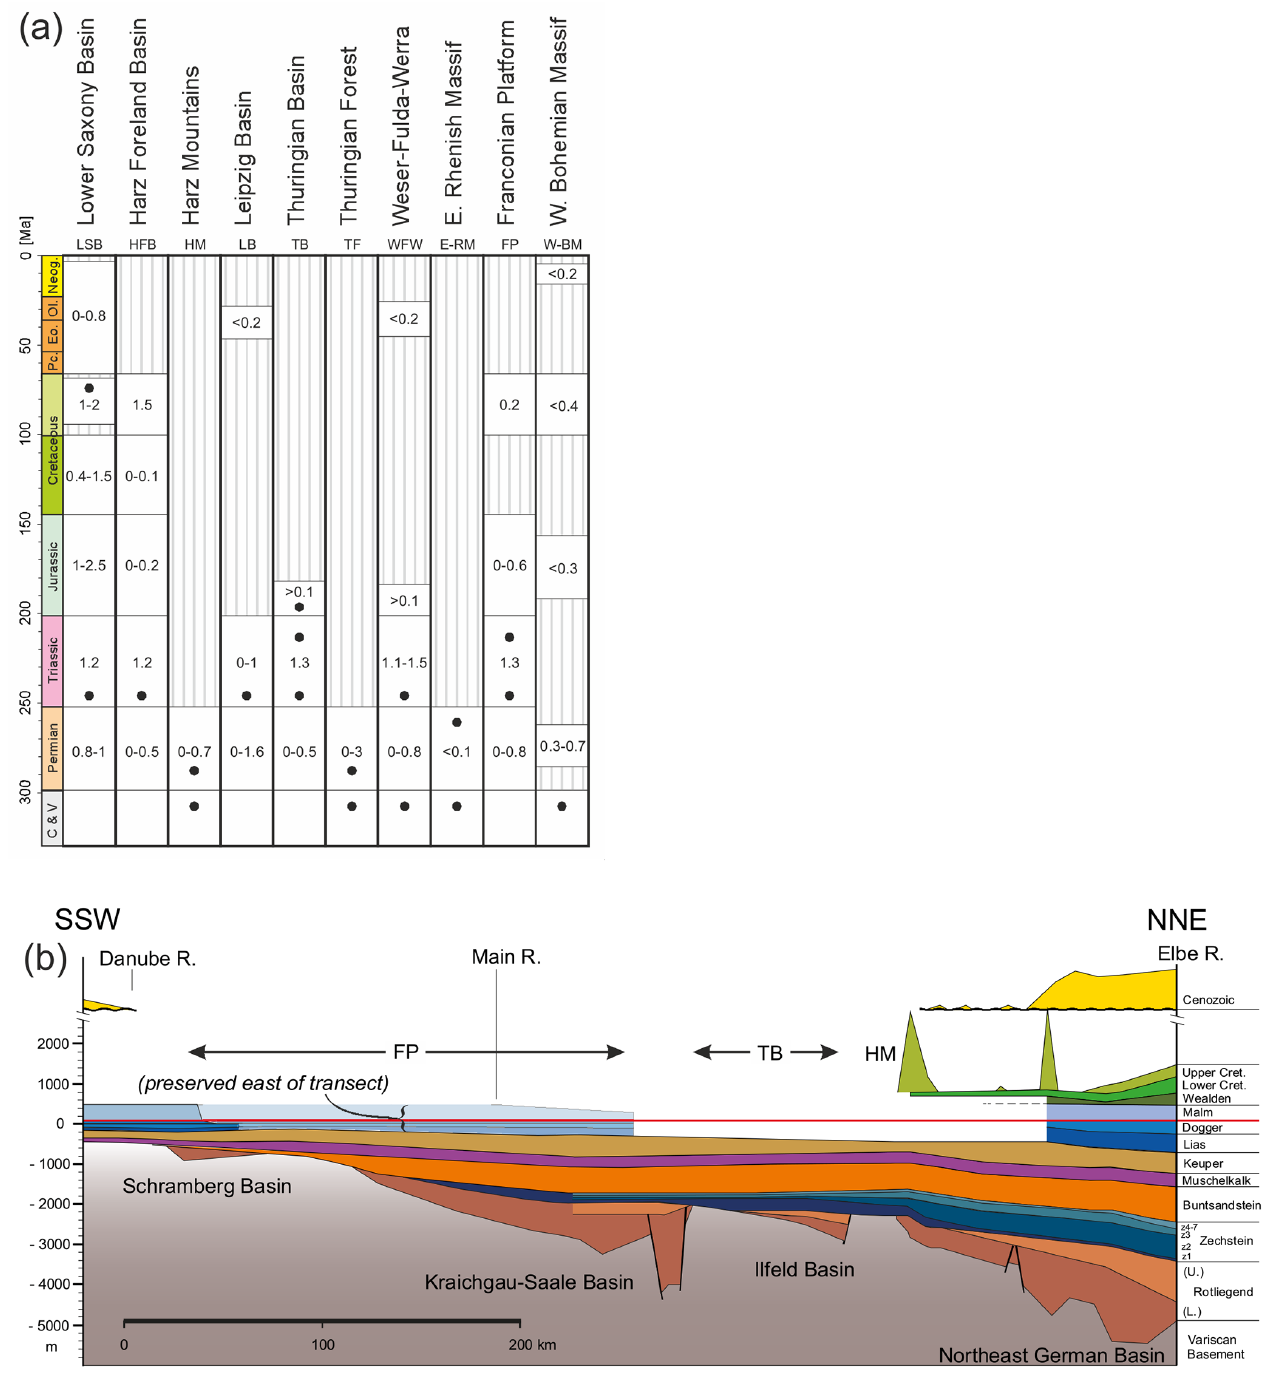
Figure 5. (a) Compilation of stratigraphical data for various geological–structural units of the study area as mentioned in the text and indicated in Fig. 3. The approximate thicknesses of the strata are given in kilometres. C and V: Carboniferous (meta)sedimentary and Variscan metamorphic or igneous basement rocks, respectively. Black dots represent the stratigraphic levels of the samples used for thermochronology. (b) Transect along the cross section in Fig. 4, showing primary variations in thickness and different preservation. The units shown in (a) are projected onto the transect if appropriate. Zechstein to Triassic strata exhibit a relatively monotonous southward thickness decrease and onlap onto Variscan basement of the southern basin margin. Eroded thicknesses of Jurassic and Cretaceous strata from the central segment are primarily constrained by thermochronological data. Thickness data are from Boigk and Schöneich (1974) and Hoth et al. (1993); contour maps can be found in Freudenberger and Schwerd (1996) and Franke (2020).